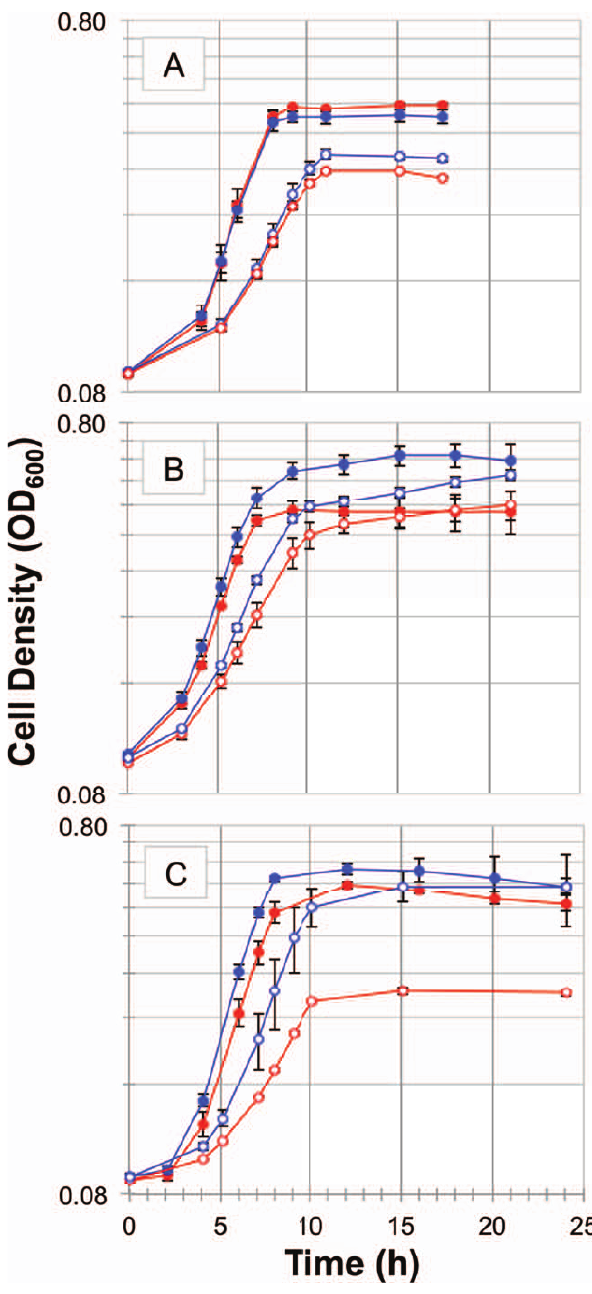
Figure 3. The growth kinetics of A. D ygiH , B. D astE , and C. D rph vs. wild type. Red lines represent the growth kinetics of wild type in absence (open circle) and presence (solid circles) of 0.5% (v/v) n- butanol. Blue lines represent the growth curves of the deletion strains in absence (open circle) and presence (solid circle) of 0.5% (v/v) n- butanol.